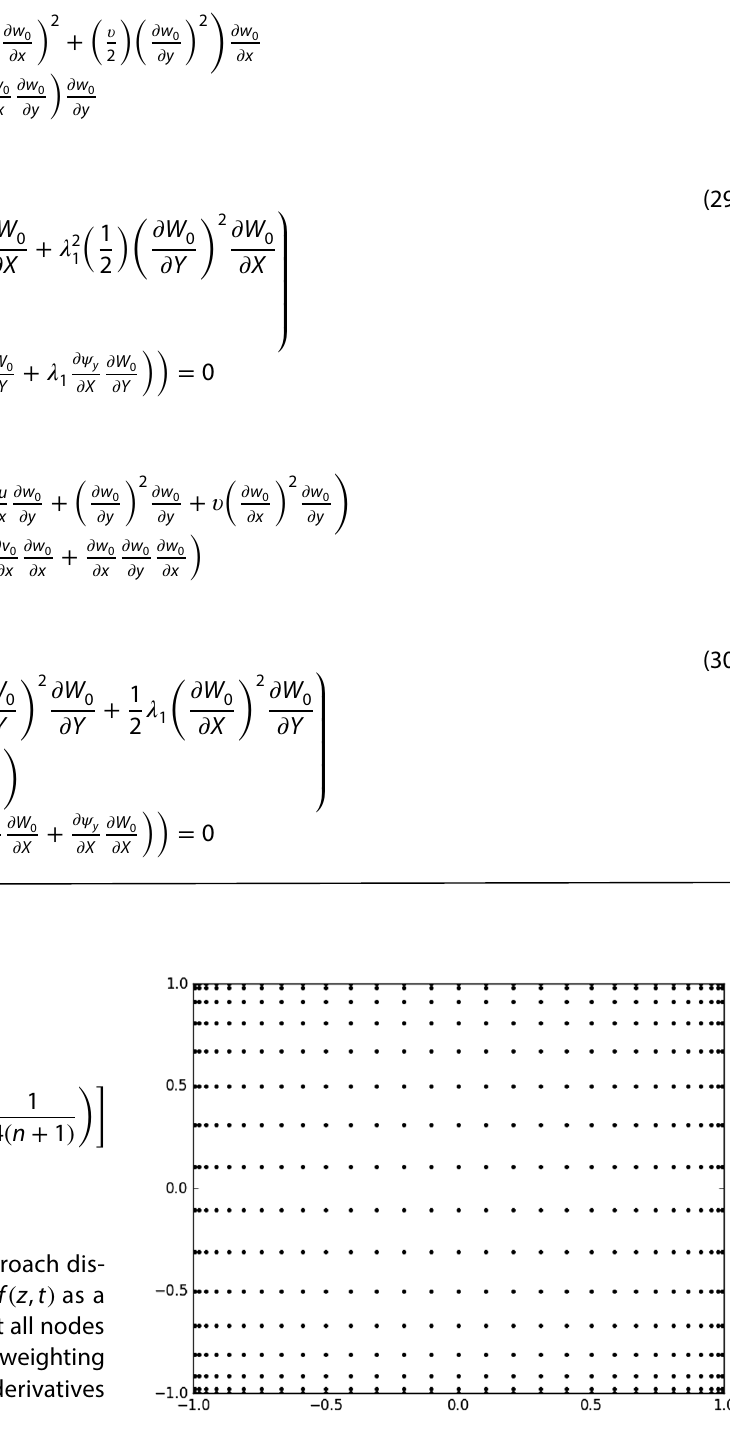
Fig. 2 Chebyshev–Gauss–Lobatto quadrature-mesh